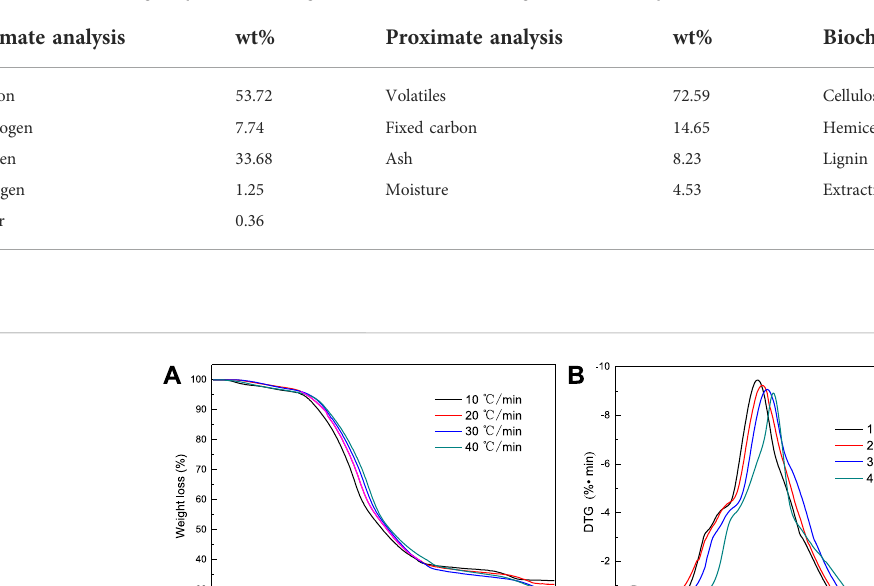
TABLE 2 Ultimate analysis, proximate analysis, and biochemical analysis of GBR sample.